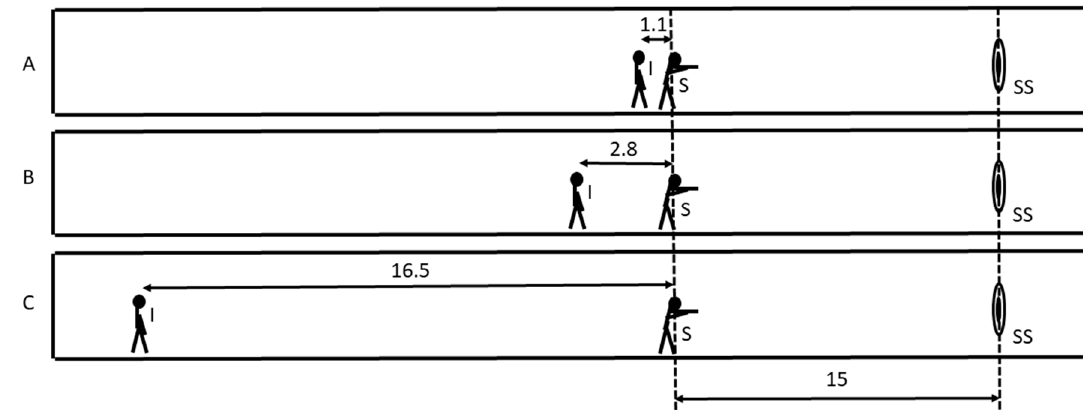
Figure 1. The three measuring situations (A, B, C) included in the measurement of noise parameters carried out at the indoor shooting range: I—shooting instructor, S—shooters, and SS—shooting target. Distances are expressed in meters.